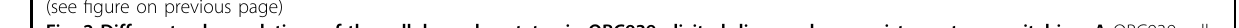
Fig. 2 Different subpopulations of the cellular redox status in QBC939 elicited diverse chemoresistance to gemcitabine. A QBC939 cells were transfected with the HyPer3 probe plasmid for 48 h and then were sorted by fl uorescence-activated cell sorting. Sorted cells were checked by confocal microscopy. B Quanti fi cation of A . C Sorted cells were checked by DCFHDA under microplate reader. D Sorted cells were treated with Gemcitabine at the indicated concentrations for 48 h. Cell viability was measured using CCK8. E The sorted cells were seeding in 6 well plates for 24 h and followed with gemcitabine treatment for 48 h at 1 and 10 μ M. Apoptotic assay by Annexin-V/PI staining for fl ow cytometry after gemcitabine treatment for 48 h. F Quanti fi cation of E . G Apoptotic assay by Hoechst dye for immuno fl uorescence after gemcitabine treatment for 48 h. H Quanti fi cation of G . Each experiment was performed in triplicate. * p < 0.05; ** p < 0.01; *** p <